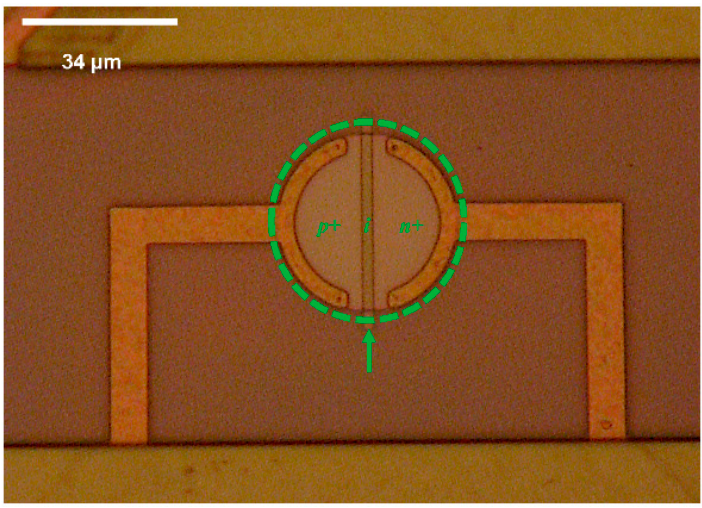
Figure 3. Micrograph of a single thermodiode used as a temperature sensor on the multi-sensor SOI CMOS MEMS chip.